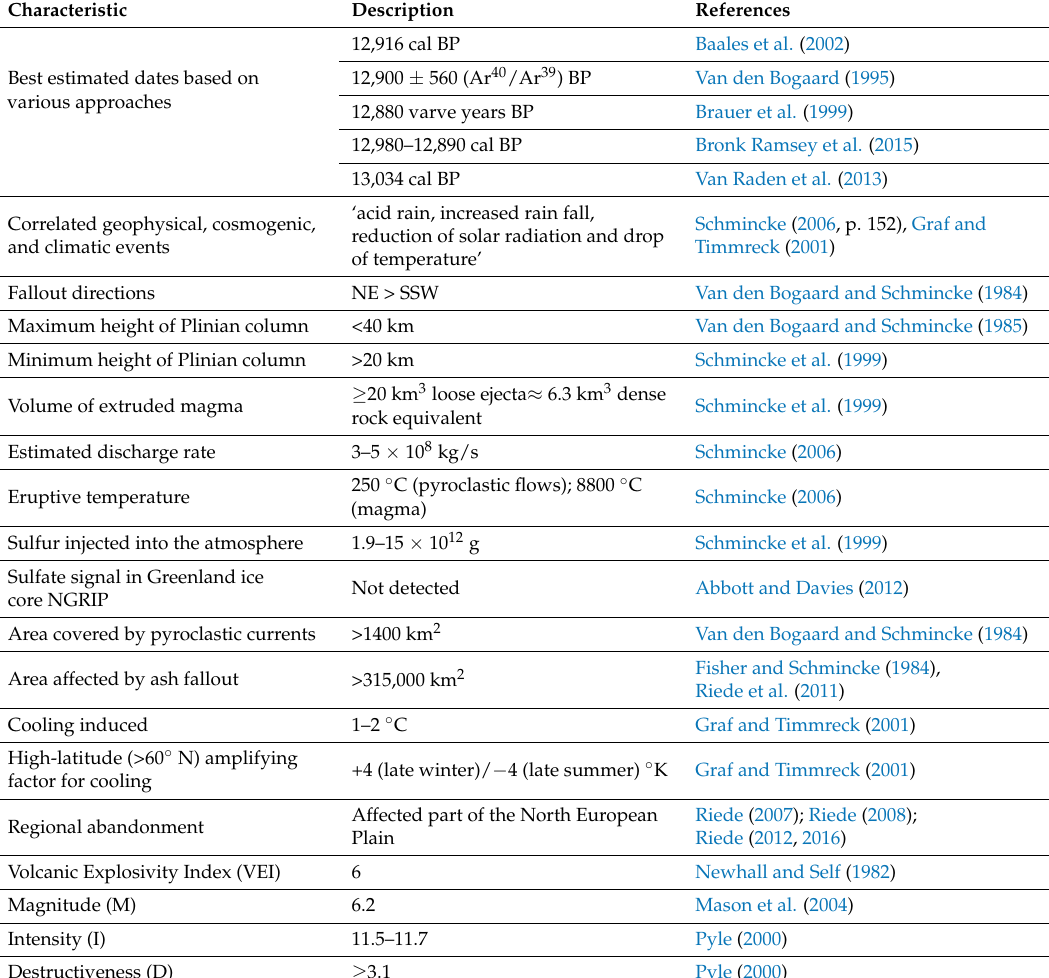
Table 2. Summary of key characteristics of the Laacher See eruption. BP = before present (1950); cal BP = calibrated years before present, i.e., the measured radiocarbon age has been converted (calibrated) to calendar